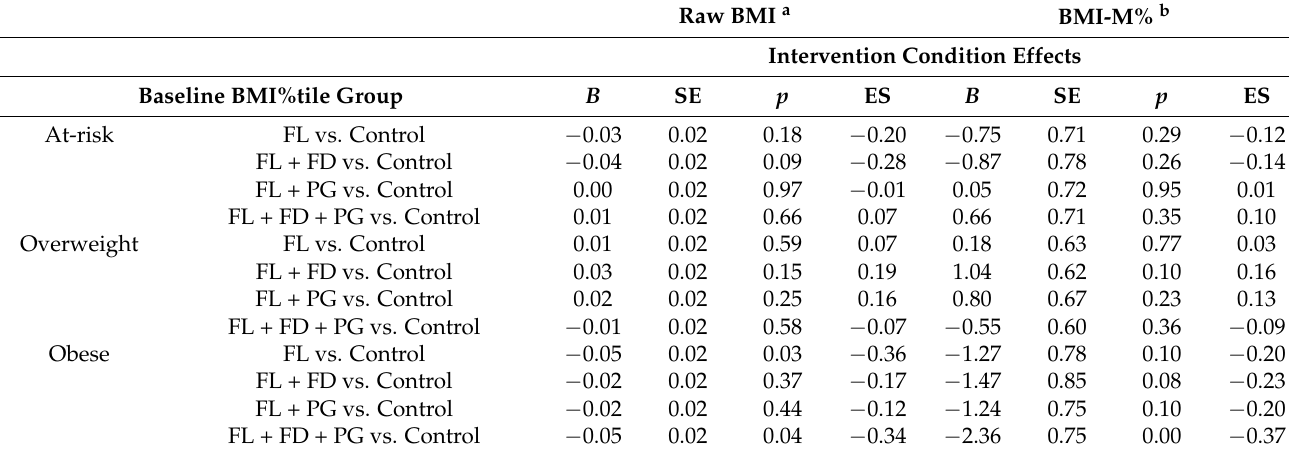
Table 5. Comparing Intervention Slope Differences to Controls with Effect Size at the Final